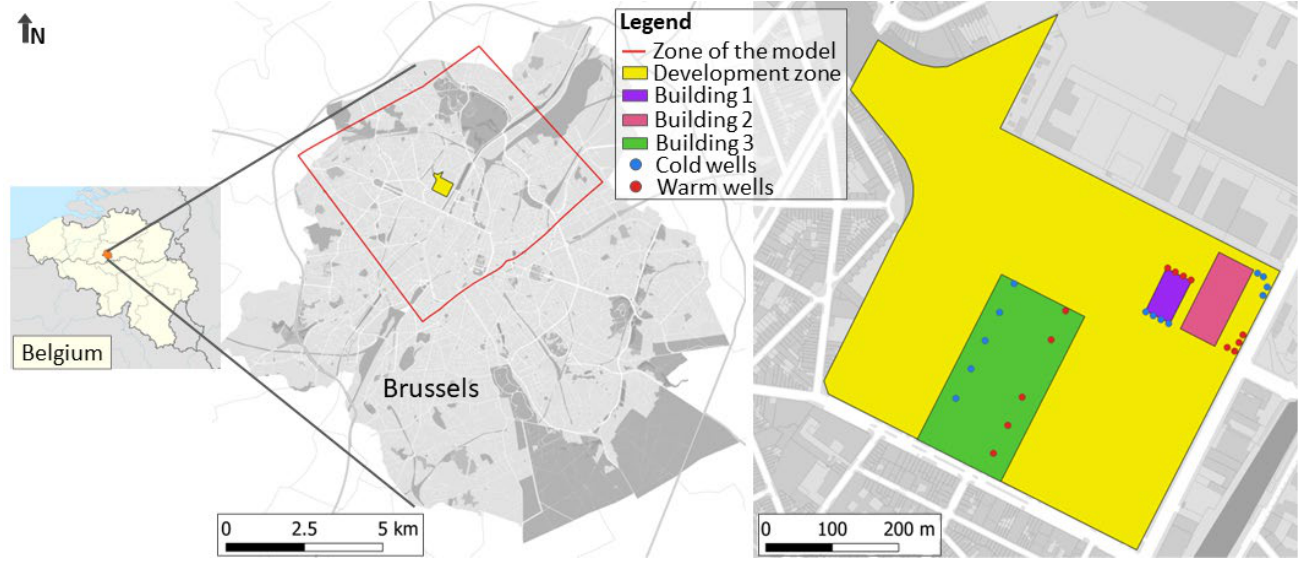
Figure 1. Location map of the study case in Brussels (Belgium). Locations of the model, development zone, and the three studied buildings and their ‘cold’ and ‘warm wells' of the ATES systems.